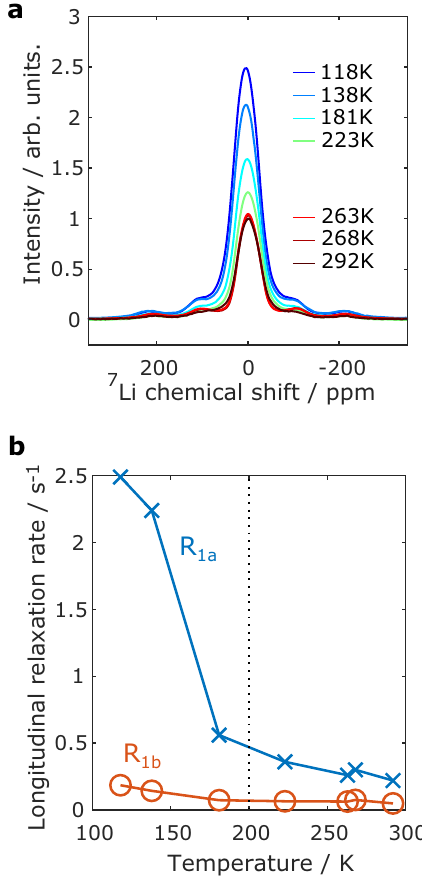
Fig. 6 Solid-state NMR on Li 2 TiSe 3 . a Static 7 Li spectra as a function of temperature. b 7 Li longitudinal relaxation components R 1a and R 1b plotted against